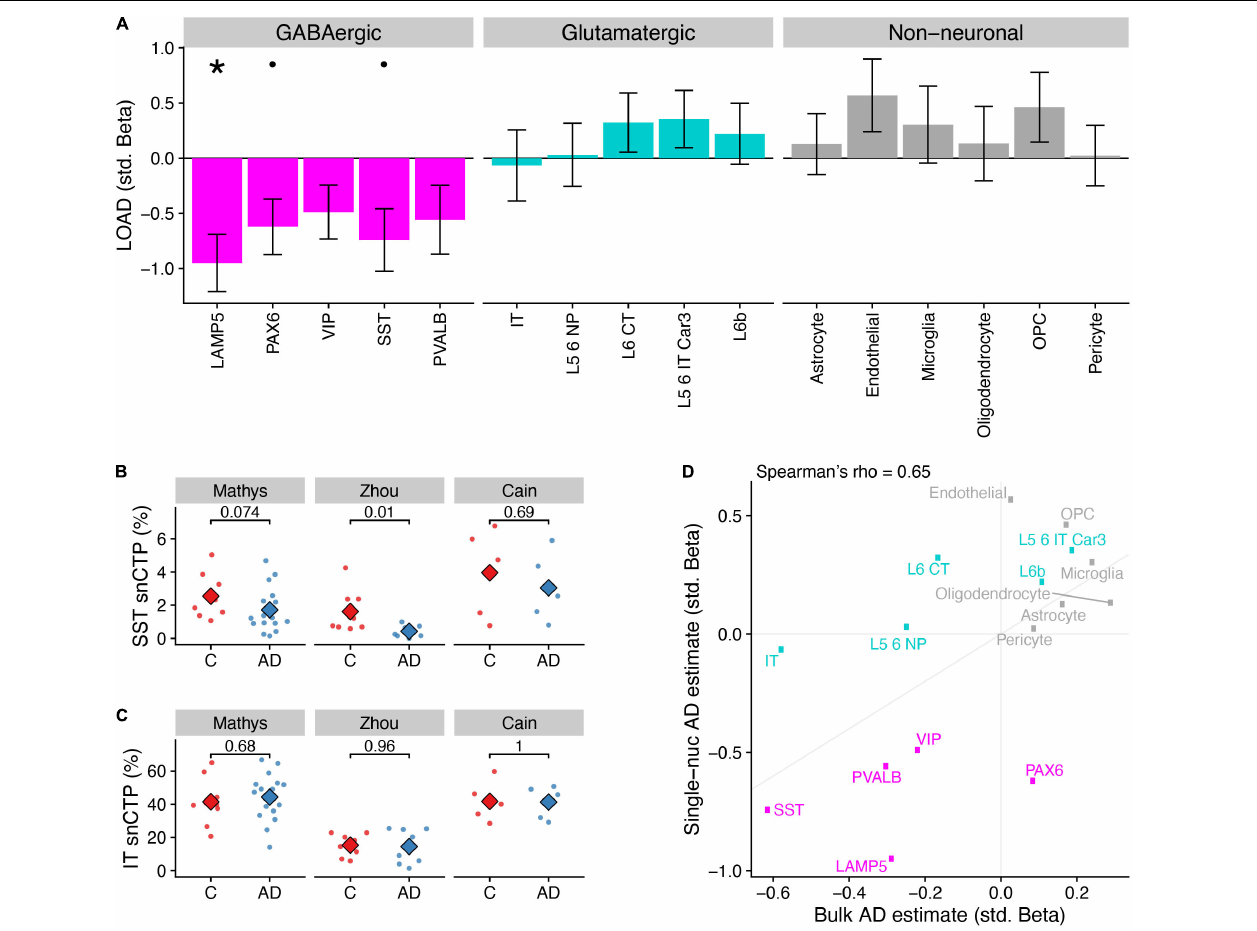
FIGURE 2 | Differences in single-nucleus derived cell type proportions (snCTPs) of neuronal and non-neuronal subclasses in Alzheimer’s disease. (A) Consensus associations of AD status and snCTPs across three AD snRNAseq case/control datasets. Y-axis shows standardized beta coefficients estimated using a mixed effects model to pool associations across datasets. Positive (negative) standardized beta coefficients indicate an increase (decrease) in the cell type-specific snCTP in AD. Error bars indicate one standard deviation. Asterisks (dots) above each cell type indicate two-sided p bonf < 0.05 (or less stringent FDR < 0.1). (B) Comparisons between snCTPs between controls and AD cases in each of three snRNAseq datasets. Y-axis dots show snCTPs for somatostatin (SST) interneurons (as a percentage of all nuclei sampled) from individual post-mortem samples. Numbers show p -values from t -test (uncorrected for multiple comparisons across datasets and cell types) from a statistical model comparing snCTPs between controls and AD cases. Subjects with outlier values of rCTPs not shown. (C) Same as panel (B) for intratelencephalic-projecting (IT) excitatory pyramidal cells. (D) Consistency of AD standardized effect sizes between bulk rCTPs and snCTPs based on single-nucleus analyses. X-axis shows point estimates of standardized beta coefficients of AD effects on rCTPs in the ROS/MAP cohort (as in Figure 1A ) and y-axis is the same as point estimates shown in A. Diagonal line denotes the unity line. Inset correlation value denotes overall Spearman correlation (rho) between rCTP and snCTP estimated